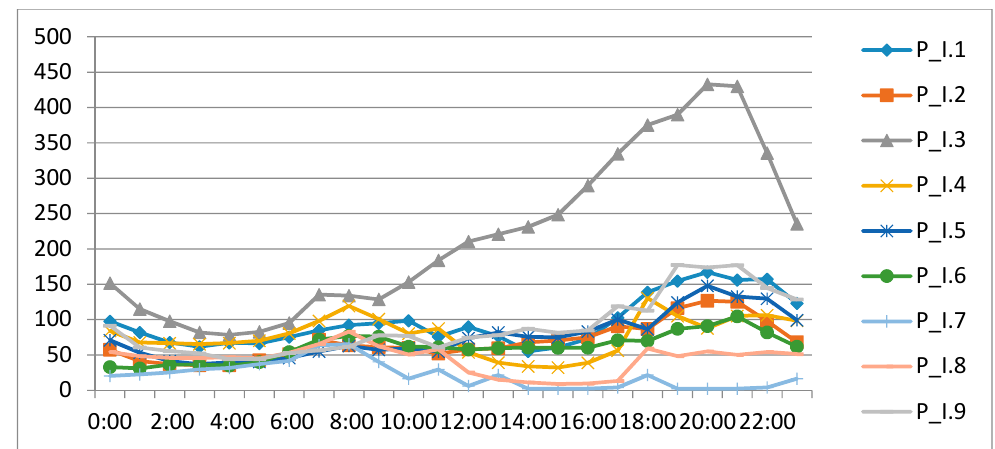
Figure 13. Load profiles obtained with 3 × 3 architecture.